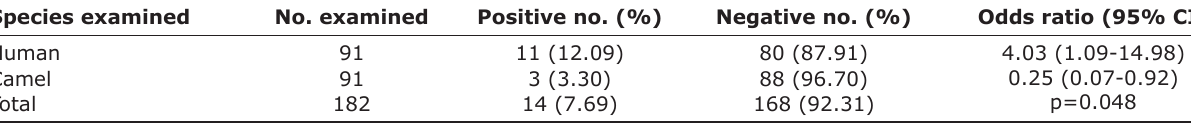
Table-1: Seroprevalence of dengue virus in humans and dromedary camels. Species examined No. examined